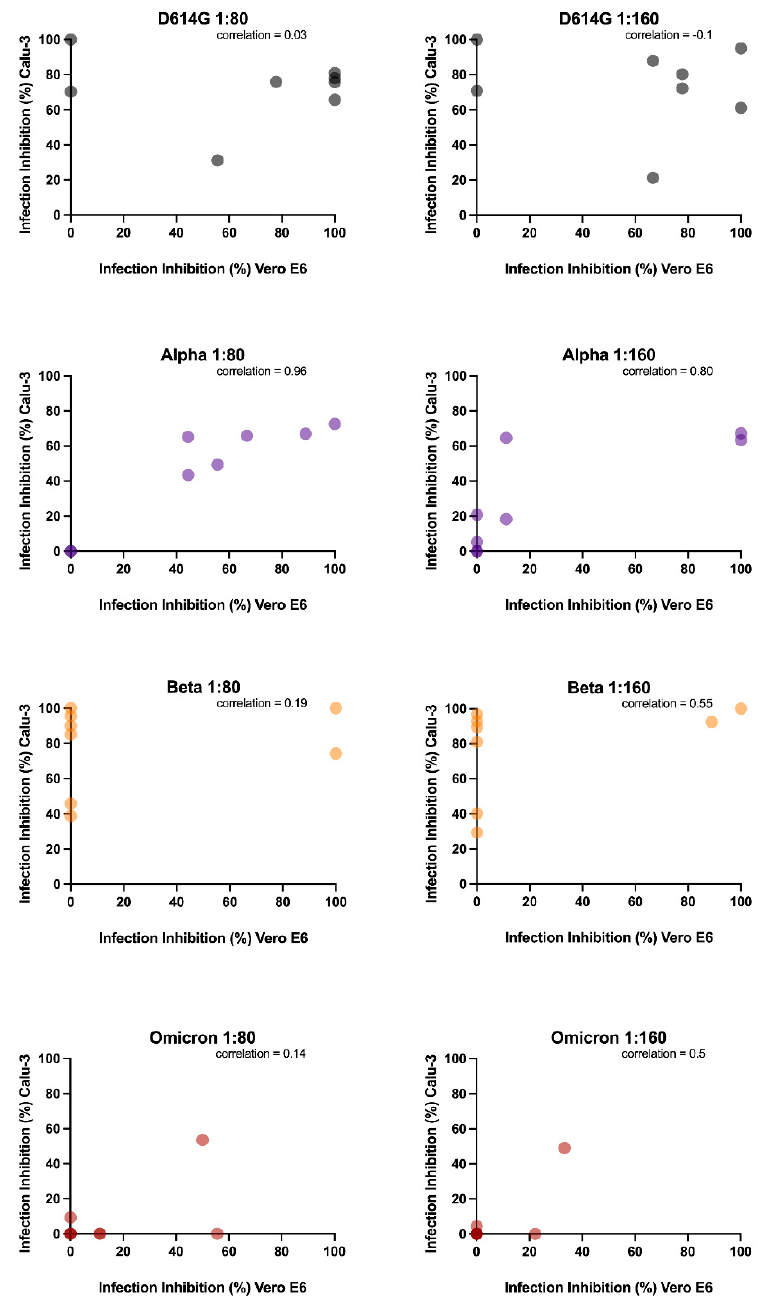
Figure 6. Correlation analysis. Analysis performed on the neutralization capability of the two tested dilutions of vaccine-induced antibodies on Vero E6 ( x axes) and Calu-3 ( y axes) against D614G, Alpha, Beta and Omicron variants.